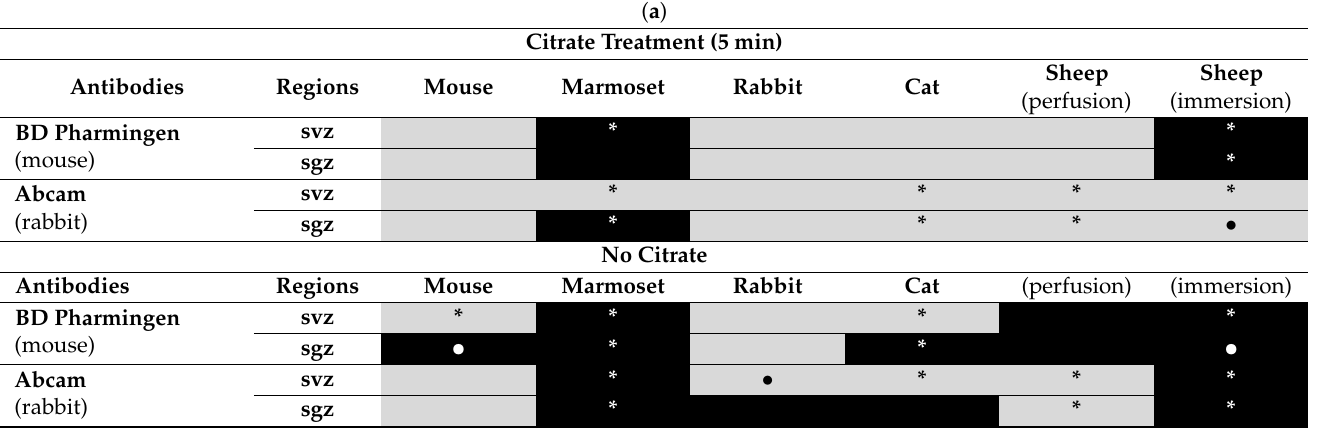
Figure 7. Variation in the type and quality of immunostaining obtained in different animal species ( A ) and in different brain regions ( B ). ( A ) In comparative studies the detection DCX+ cell populations can yield different results depending on real interspecies differences, e.g., the absence of DCX+, immature neurons in the mouse neocortex [23]. ( B ) Even in the same species, using the same antibody, different results can be found depending on the brain region. In most cases, the SVZ bordering the lateral ventricle (LV) stains far more clean and clear with respect to parenchymal regions such as the cortex and the hippocampus (sheep and cat). Note that in sheep, SVZ and cortex stain for the expected neuronal populations and non-specific staining is detectable in the hippocampus. Scale bar: 30 µm. Table 4. ( a ) Occurrence and quality of staining for Ki67 antigen. ( b ) Merge (with and without citrate